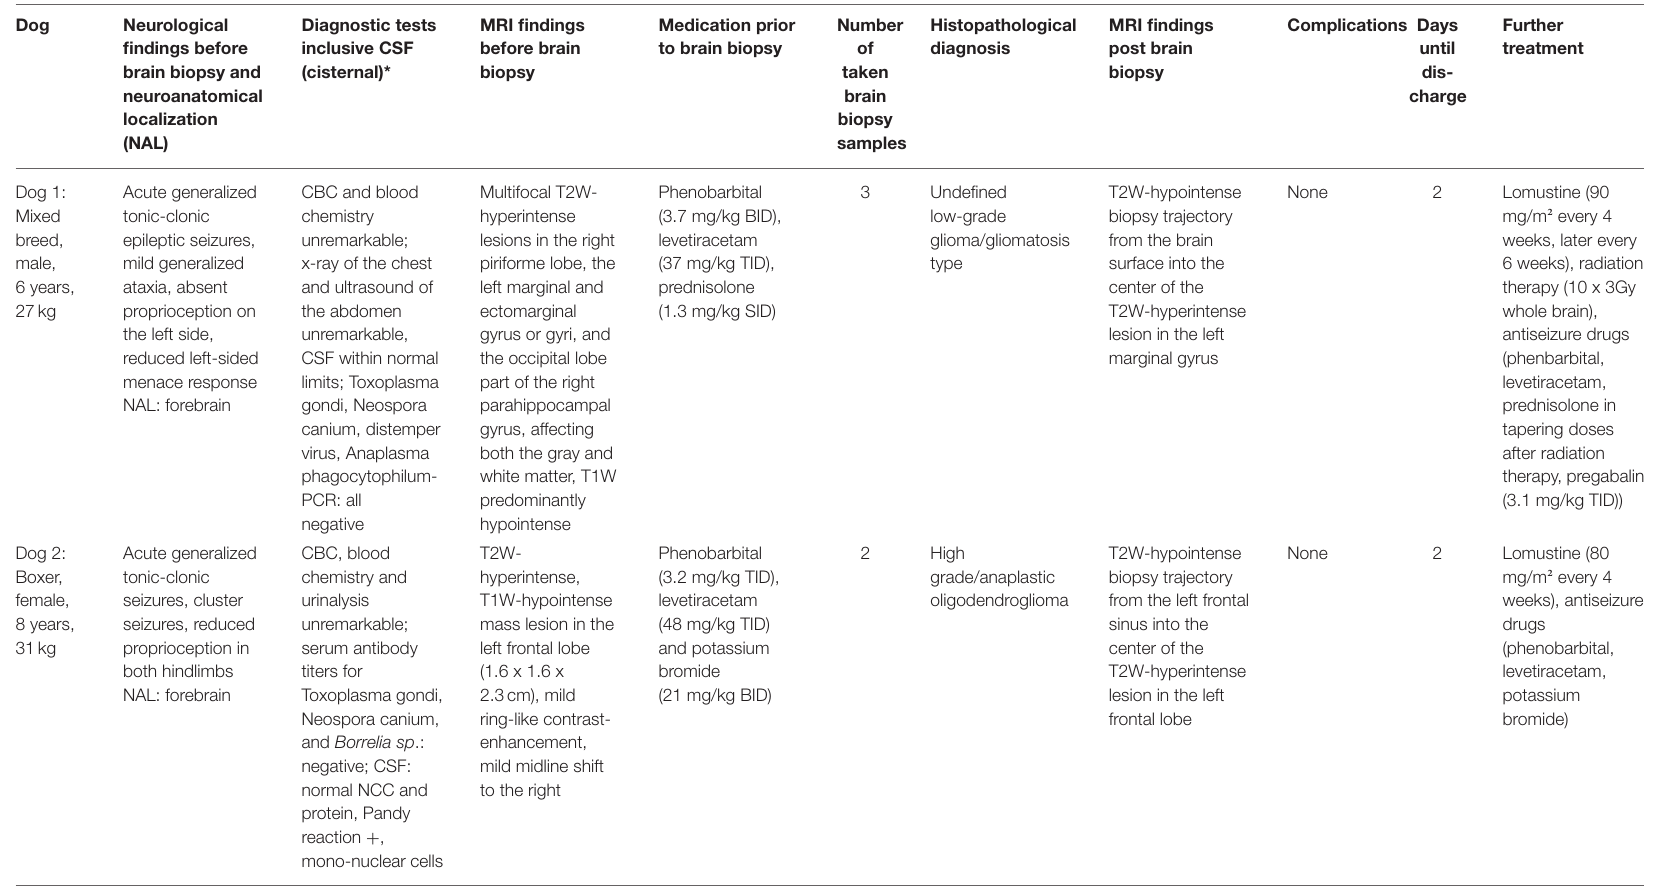
TABLE 1 | Results of neurological examination before the brain biopsy procedure, diagnostic tests including CSF analysis and MRI findings, medication prior to brain biopsy, the number of the biopsy samples taken, histopathological diagnoses, MRI findings post brain biopsy, complications, duration of hospitalization, and further treatment for each dog.